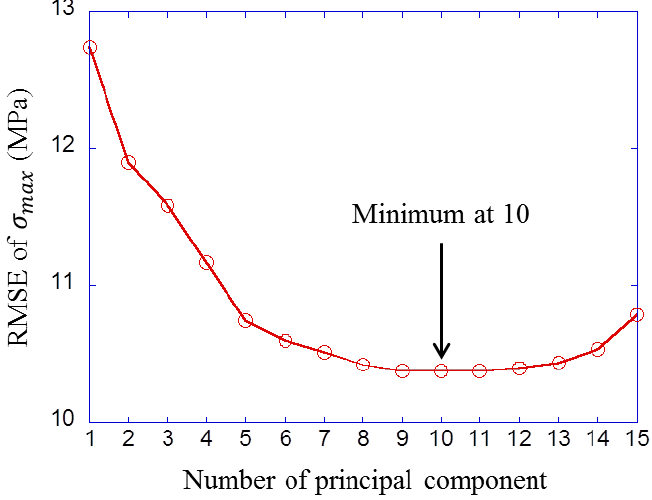
Figure 11. Result of parameter selection in linear regression model.